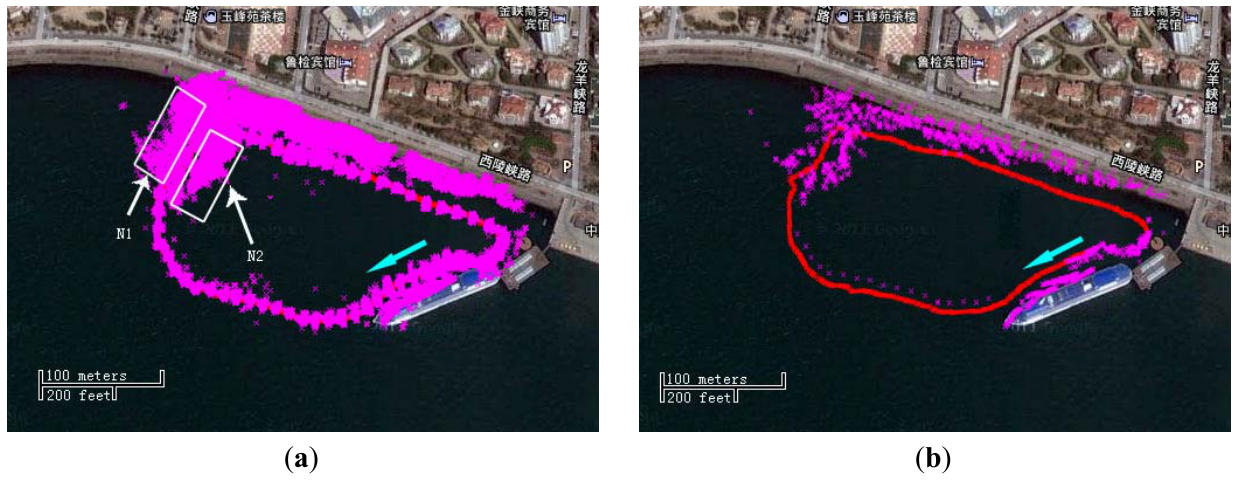
Figure 10. ( a )The satellite image combined with the sonar image without sparsification (the pink points) and the GPS path (the red line); ( b ) The figure after sonar feature extraction and